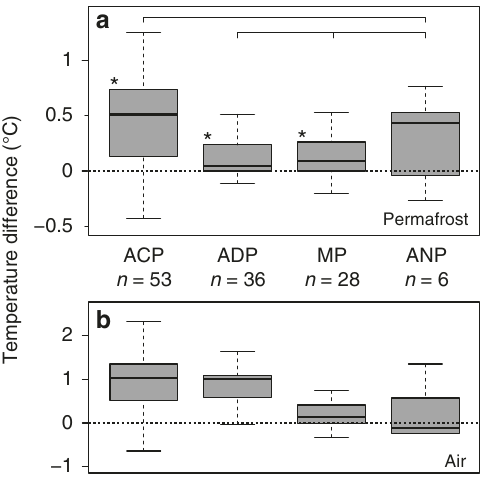
Fig. 5 Decadal temperature change rates at permafrost borehole sites. a Boxplots showing the regional (unweighted) distribution of permafrost temperature change rates near the depth of zero annual amplitude Z * calculated for 2007 – 2016 in °C per decade (Eq. 3). * indicate signi fi cant difference to 0, p < 0.05 de fi ned by the Wilcoxon Signed-Rank test. p values ACP: 0.000, ADP: 0.002, MP: 0.016, and ANP: 0.156 (rounded to three digits). The Kruskal – Wallis test indicated p values > 0.05 for couples that discontinuous permafrost, MP mountain permafrost, ANP Antarctic